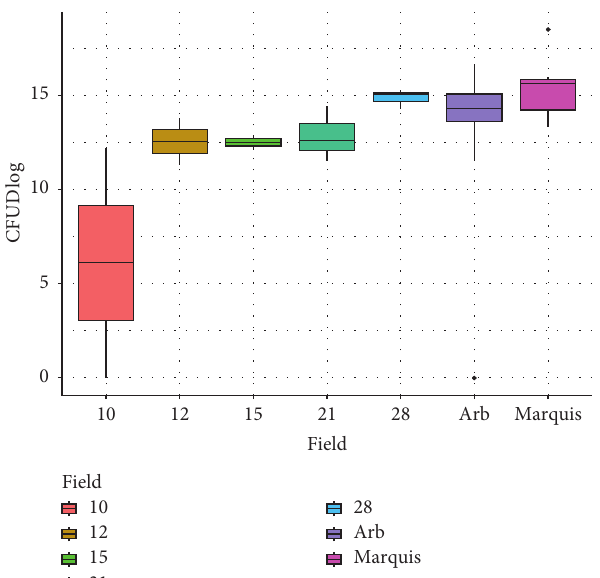
Figure 4: Comparison of log-transformed bacterial growth rates for 10 − 4 dilution by